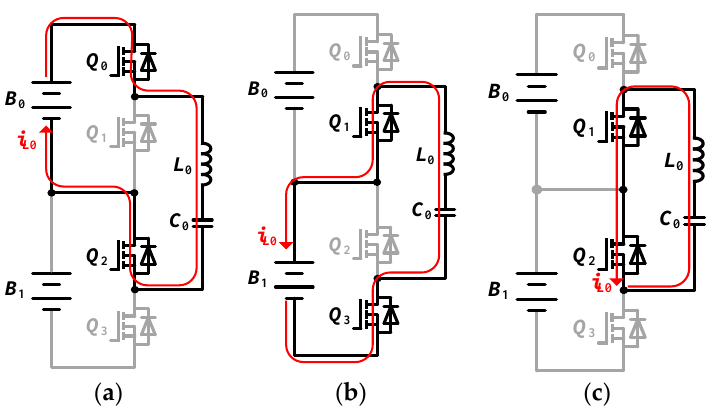
Figure 7. Switching sequences of the proposed equalizer at V B 0 < V B 1 .